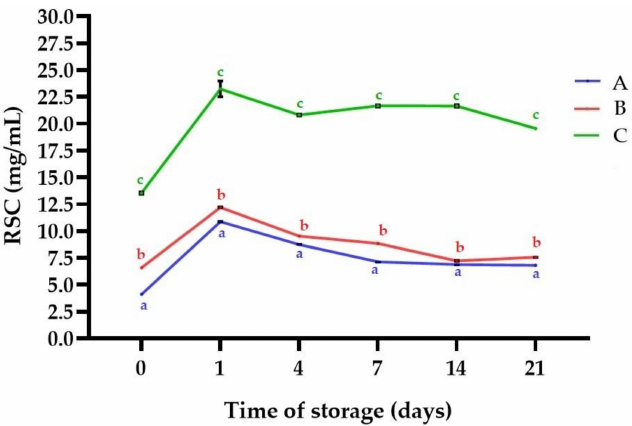
Figure 2. Reducing sugars content (RSC) of the samples during storage time. Means with di ff erent lowercase are significantly di ff erent at p < 0.05. A —sample with 5% ( w / w ) lupin seeds content,